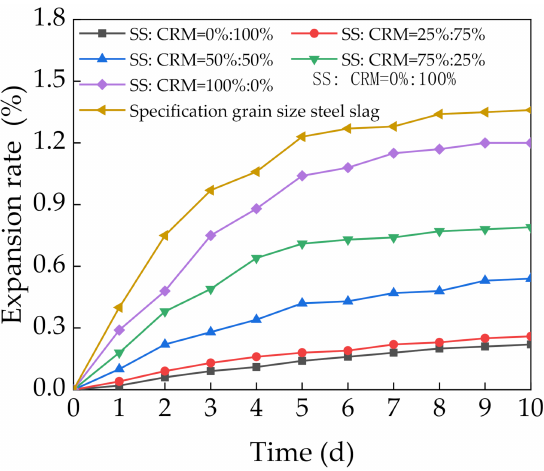
Figure 6. Variation curve of the immersion expansion